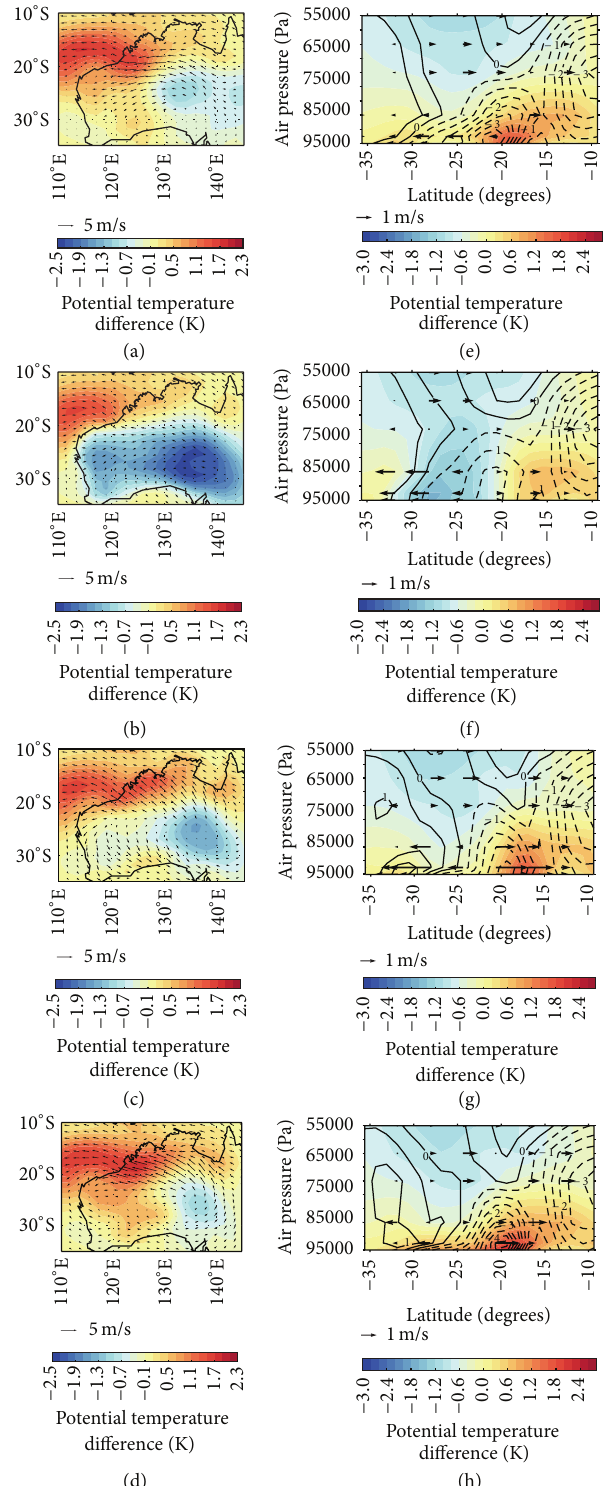
Figure 4: (a)–(d) show the difference in climatological mean (1979–2001) potential temperature (K) and horizontal wind speed (ms −1 ) at 925 hPa between A1.1 and A1.0 at 0800, 1400, 2000, and 0200 AWST, respectively. (e)–(h) show the difference in potential temperature and horizontal wind speed at 125 ∘ E between A1.1 and A1.0 at 0800, 1400, 2000, and 0200 AWST, respectively. The colored contours show the difference in potential temperature. The meridional and vertical wind speeds are indicated by the arrows (scale under each figure) and the zonal wind speeds are shown as the black contours. The dotted and solid black lines represent the zonal flow into and out of the page, respectively. The vertical component is multiplied by a factor of 100 to make it